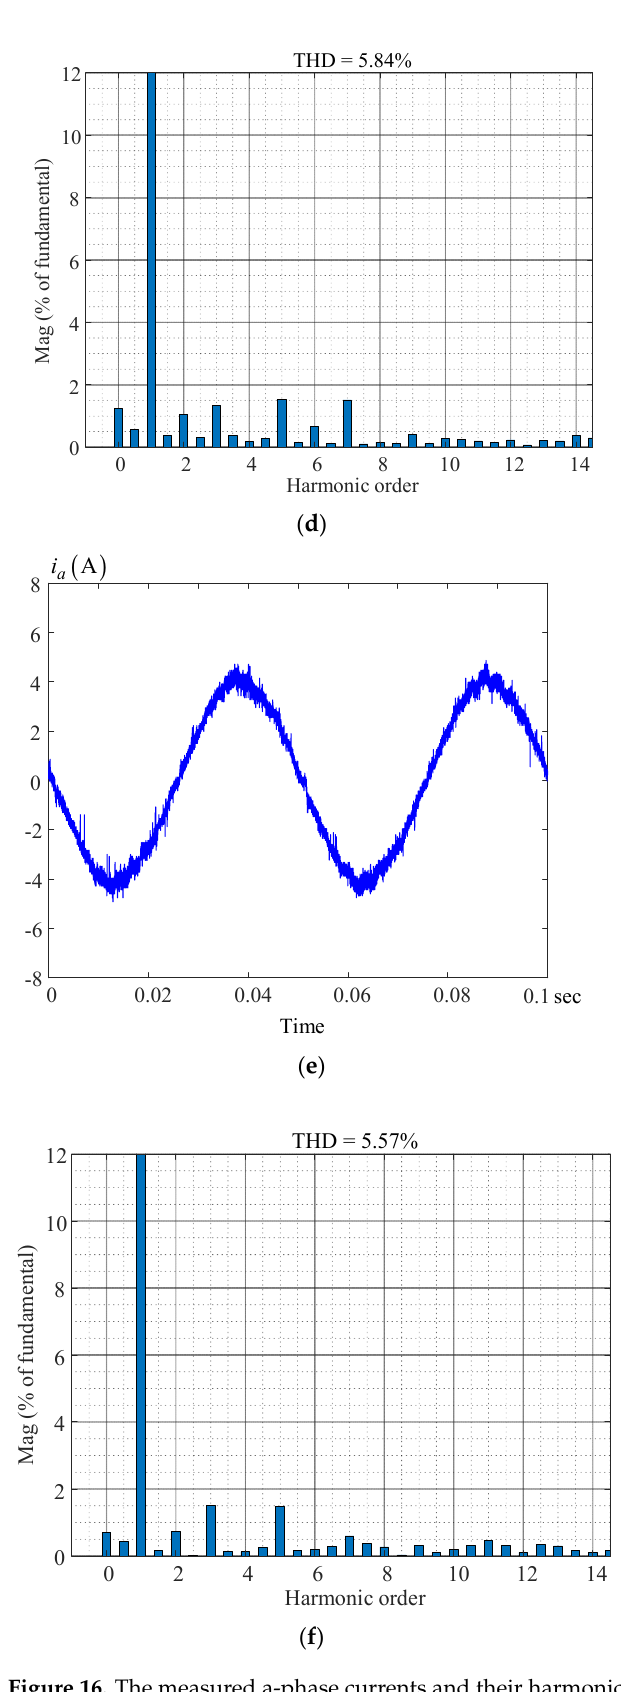
Figure 16. The measured a-phase currents and their harmonics: ( a ) current using PI; ( b ) harmonics using PI; ( c ) current using SHC; ( d ) harmonics using SHC; ( e ) current using CPC; ( f ) harmonics using